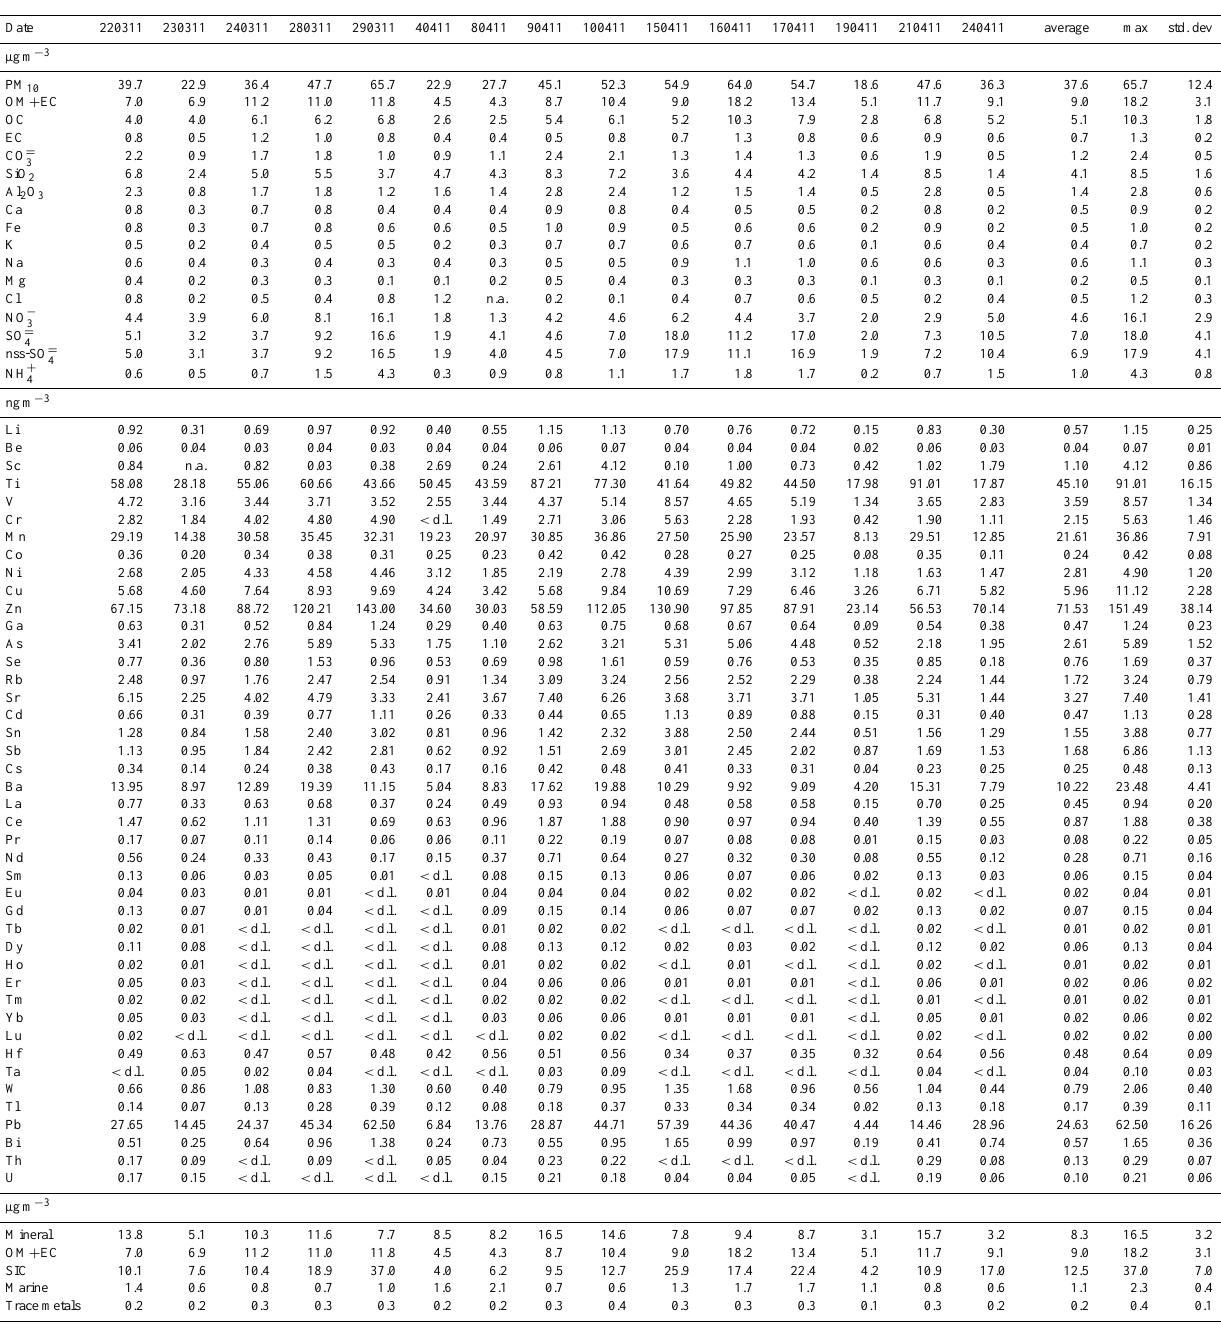
+ SiO + Al + Ca + Fe + K + 2 2 O 3 3